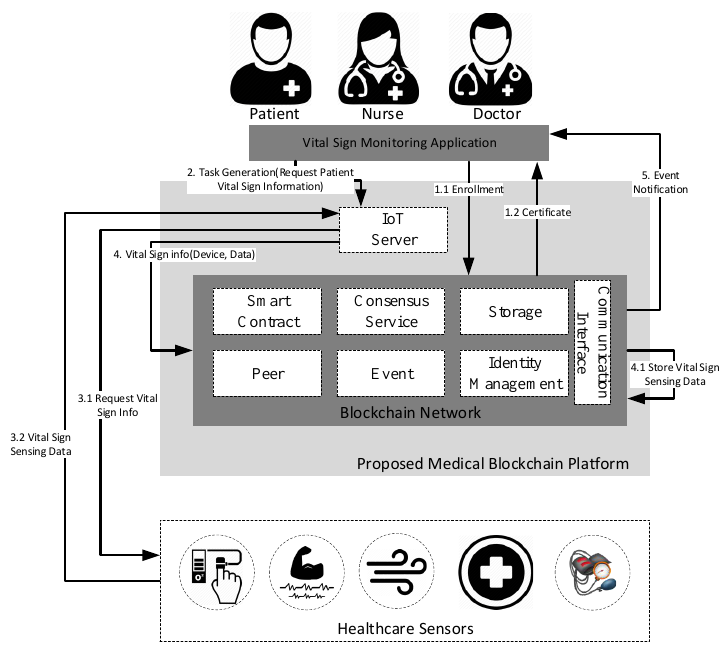
Figure 3. System workflow of the proposed healthcare IoT blockchain